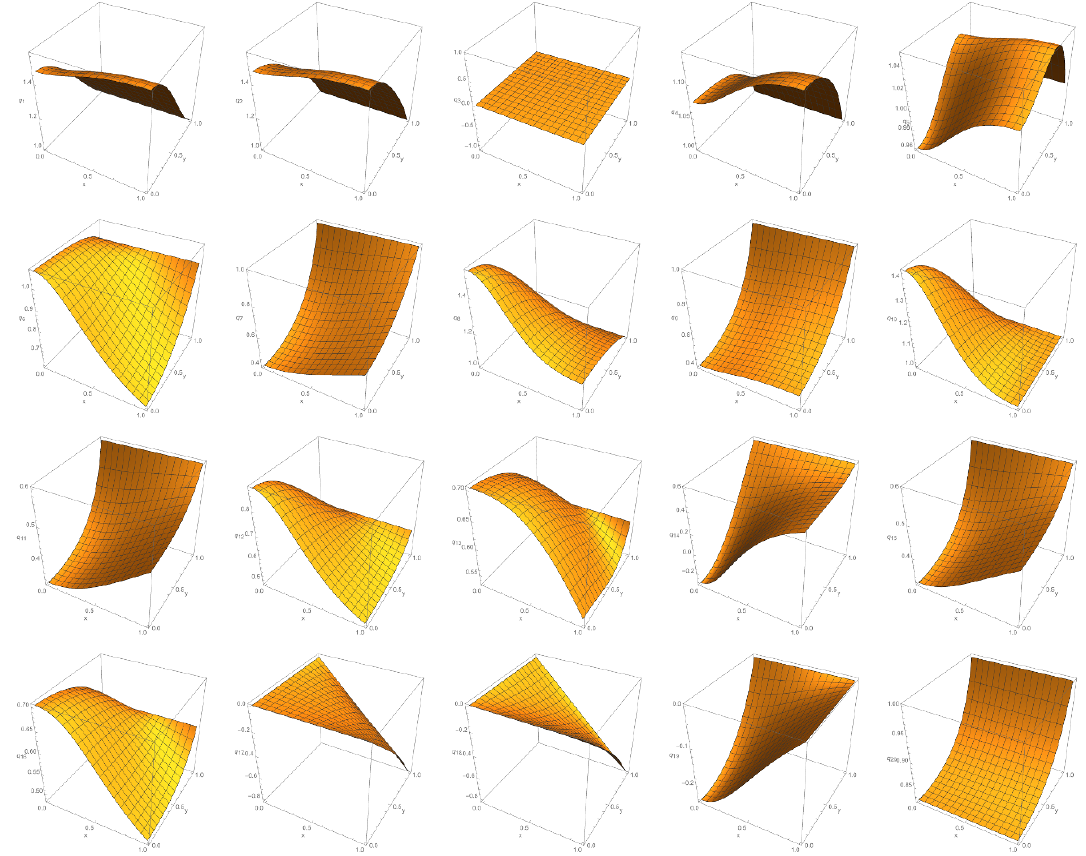
Figure 9 . The 20 functions q i (in order i = 1 : : : 20) solved numerically, for ^ m = 3 (cid:25)= 5 with y + =